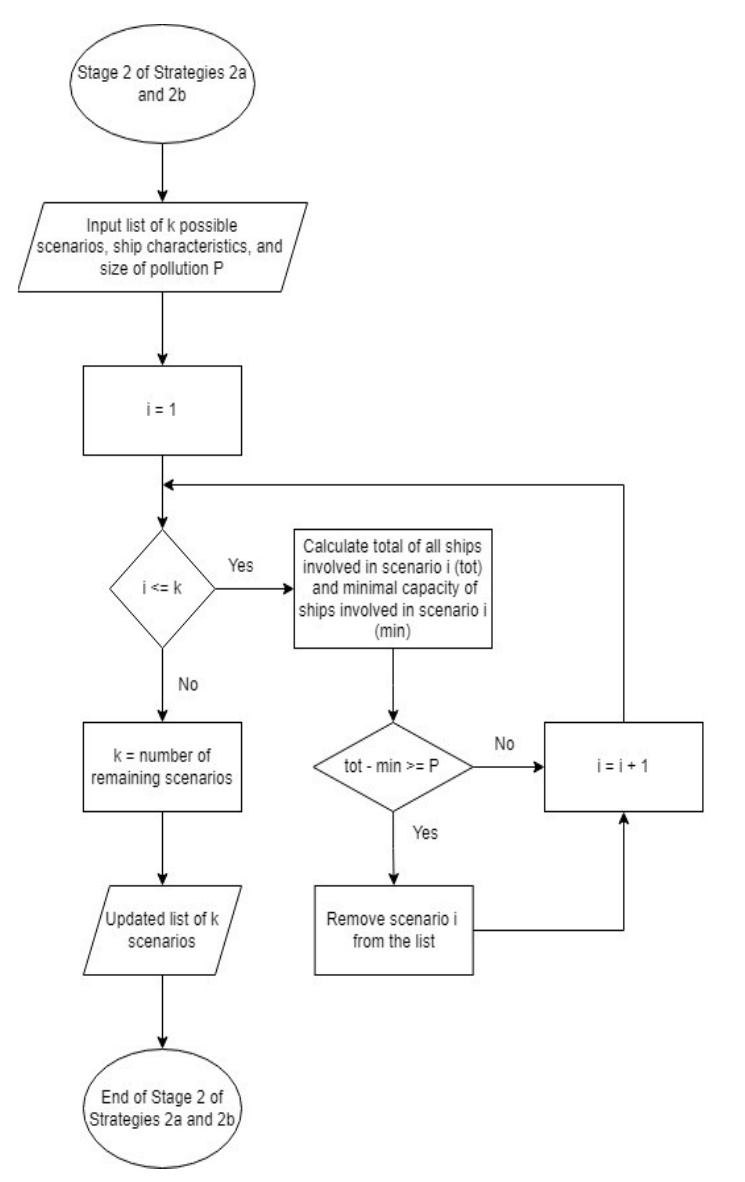
Figure 6. Flowchart for Stage 2 of Strategies 2a and 2b.